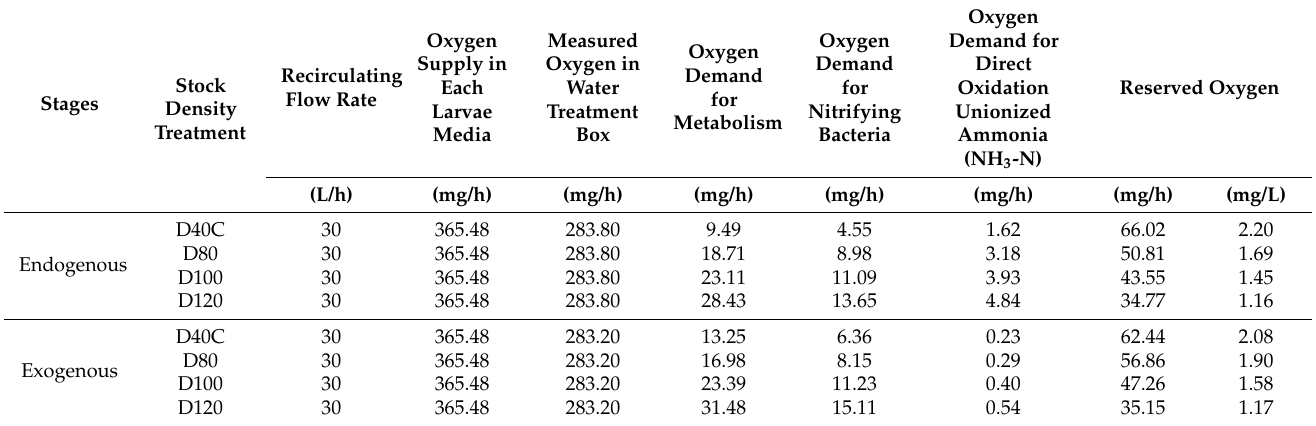
Table 6. Mass balance, oxygen demand, and oxygen reserved in UFBs-RAS used for striped catfish ( Pangasianodon hypophthalmus